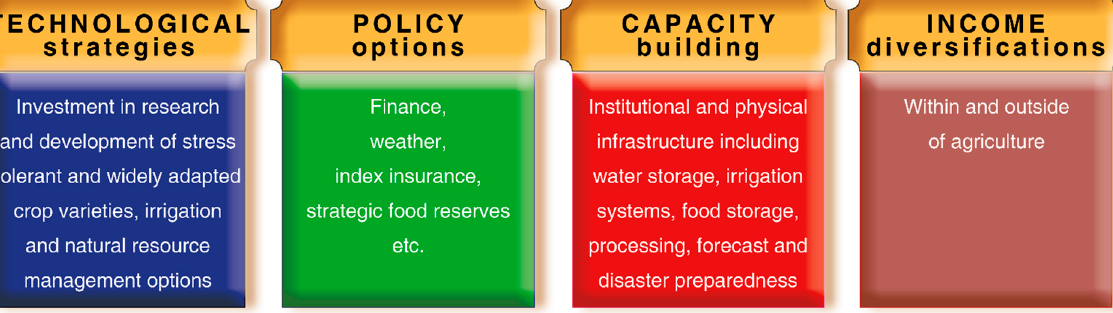
Figure 2. Approaches involved in conventional breeding in traditional